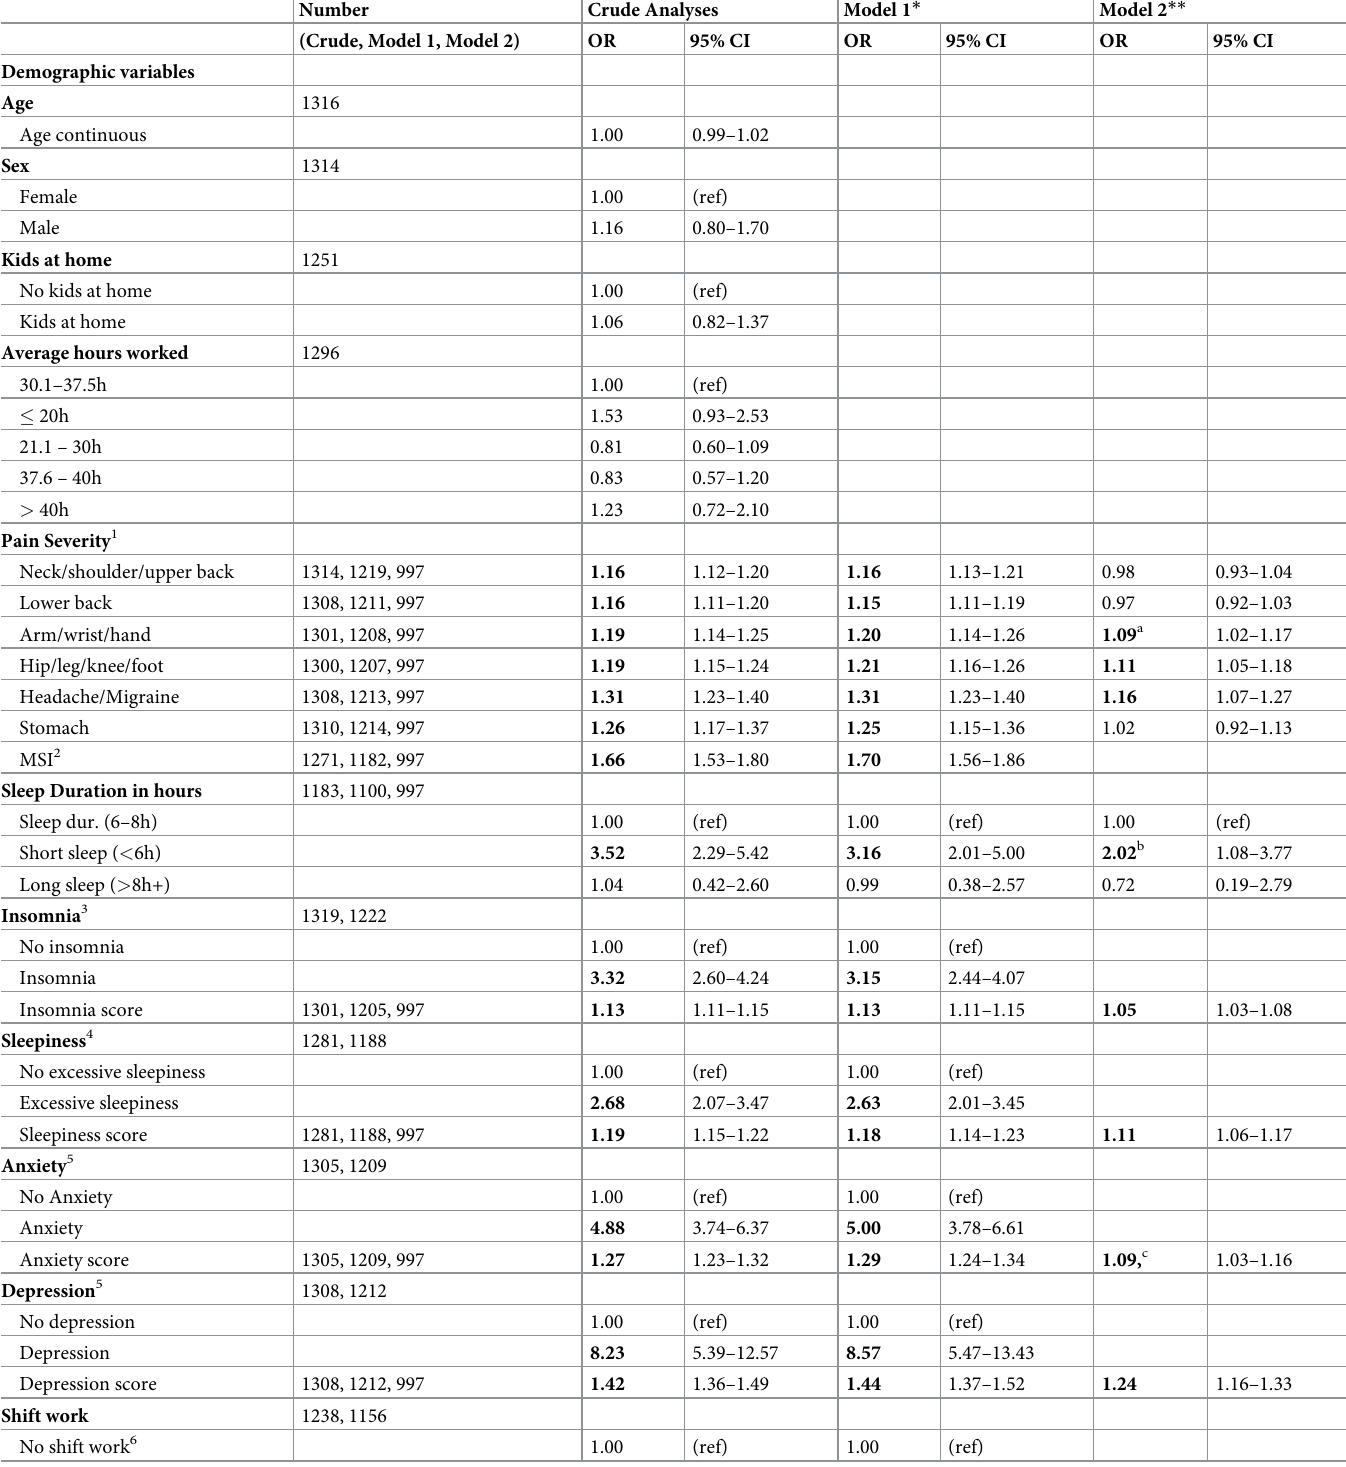
Table 4. Crude and logistic regression analyses with excessive fatigue as the dependent variable among 1335 Norwegian nurses participating in the survey of shift work, sleep and health, wave 10